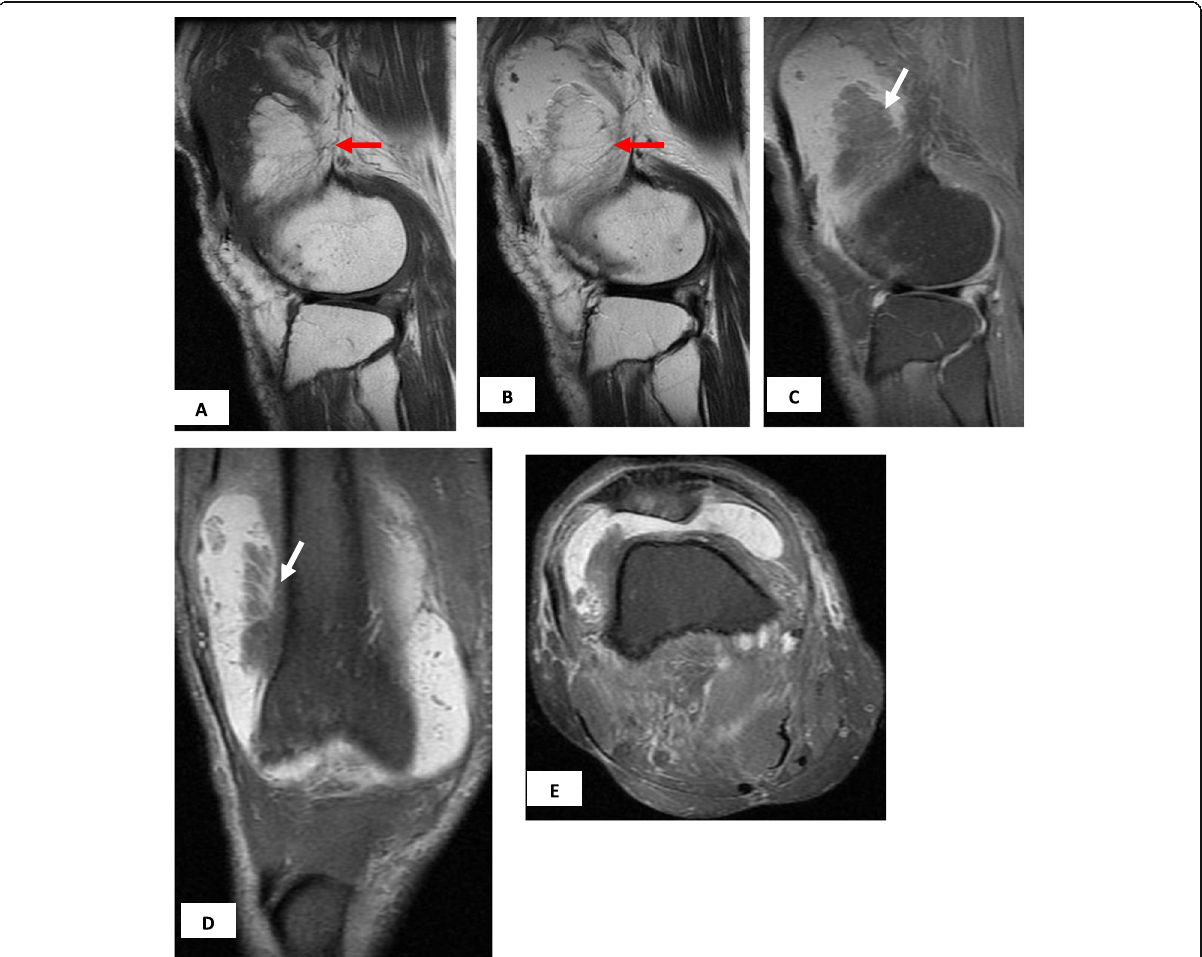
Fig. 1 Lipoma arborescence in 49-year-old male with knee swelling. Sagittal T1 ( a ) and sagittal T2 ( b ) show suprapatellar lobulated fat signal lesion (red arrows). Sagittal ( c ), coronal ( d ), and axial ( e ) STIR show loss of signal of the synovial fatty lesion (white